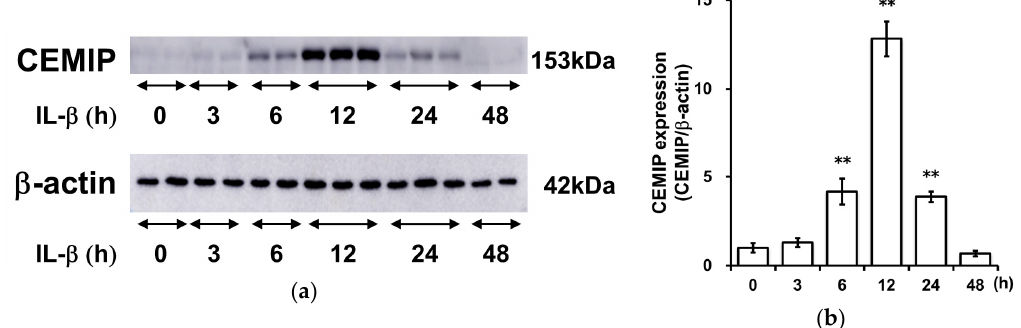
Figure 3. IL-1 β induces CEMIP protein expression. ( a ) OUMS-27 cells were treated with IL-1 β for 0 to 48 h. CEMIP protein was then detected by Western blot analysis. ( b ) Results of densitometric analysis. The densitometric values of immunoreactive bands for CEMIP were divided by respective values for β -actin. The normalized data are expressed as fold change relative to the values in unstimulated cells. Values represent mean ± SD ( n = 3 per group). ** p < 0.01 vs. control.